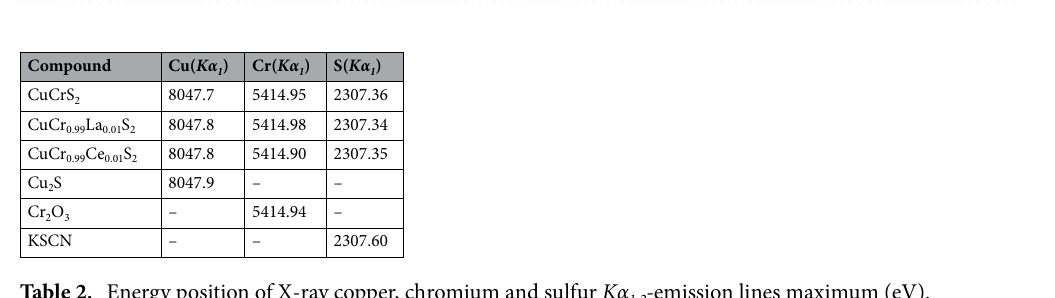
Figure 1a shows the XPS Cu( 2p 3/2,1/2 )-lines of CuCr 0.99 Ln 0.01 S 2 (Ln = La, Ce) powder samples. The Cu(2 p )- region exhibits two intense peaks corresponding to 2 p 3/2 and 2 p 1/2 levels (~ 932 and ~ 952 eV, respectively) and two groups of the satellite lines Sat (~ 943–946 and ~ 960–965 eV, respectively). The satellite lines are characteristic for Cu 2+ compounds and arising due to shake-up states corresponding to the p 5 d 9 electronic configuration 20 . The Cu(2 p 3/2 )- and Cu(2 p 1/2 )-lines could be represented as a superposi- tion of lines arising from the nonequivalent copper atoms (marked as I and II in Fig. 1) related to the different oxidation states 21–23 . The copper oxidation state analysis was carried out using the binding energy (BE) value of Cu(2 p 3/2 )-lines (Table 1). The BE value of low energy I component (~ 932.5 eV) is typical for the compounds containing Cu + (BE(Cu BE(CuSO 4 ) ≈935.4 eV) 19,24,25 . The high energy components II are assumed to include the defected near-surface layers 22,26,27 . These layers contain oxygen-contained compounds of Cu 2+ . This fact is additionally approved with effective atomic charges in molecules and solids. The main difference between these two experimental techniques is that in contrast to XPS, XES allows one to determine the atom oxidation state in the in the bulk. Thus, the combination of both XPS and XES allows one to obtain the total data on the atomic charges in CuCr 0.99 Ln 0.01 S 2 (Ln = La, Ce). The XES Cu K α 1,2 -spectra for CuCrS 2 -matrix and lanthanide-doped CuCr 0.99 Ln 0.01 S 2 (Ln = La, Ce) solid solu- tions are depicted in Fig. 2a. The Cu K α-region exhibits two intense peaks corresponding to the 2 p 3/2,1/2 → 1 s transitions. The line-shape of the Cu K α 1,2 -spectra does not significantly change after the cationic substitution. Note that additional oxidation forms of copper were not observed in the Cu K α 1,2 - region. This fact indicates that Cu 2+ forms arising in the Cu2 p -region are contained only in the defected near-surface layers. The energy position of the Cu K α 1 -line maximum for CuCr 0.99 Ln 0.01 S 2 lies within the range of 8047.7–8047.8 eV (Table 2). The measured values are typical for Cu + atoms and agree well with one for Cu 2 S reference compound contain- ing monovalent copper atom. Thus, one can conclude that the copper atomic charge is preserved after cationic substitution of CuCrS 2 -matrix with Ce and La atoms. The XPS Cr(2 p 3/2,1/2 )-lines are depicted in Fig. 1b. The Cr(2 p )-region exhibits two intense 2 p 3/2 and 2 p 1/2 spin doublet components (~ 575 and ~ 584 eV, respectively). The main 2 p 3/2 - line could be presented as a superposi- tion of two components ( I and II ) related to the different oxidation states. The BE of the low energy I component